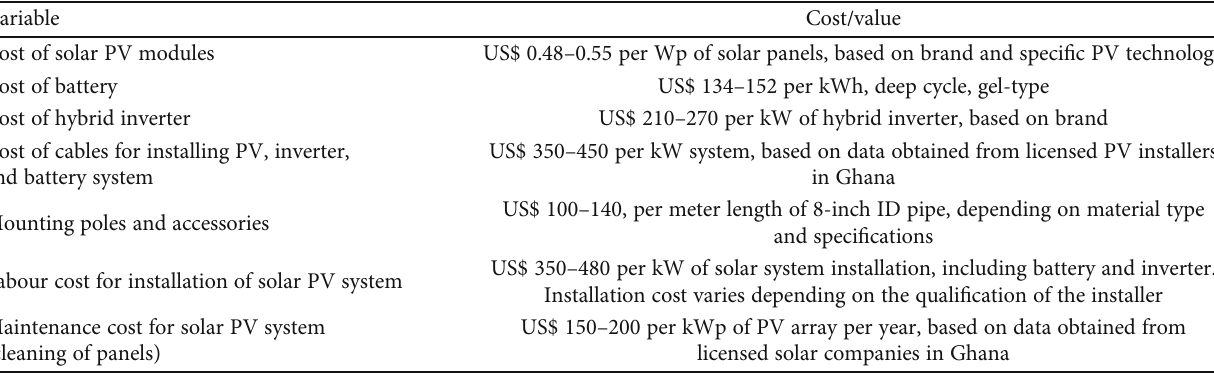
Figure 2: Standalone solar PV system at the CHPS compounds. Table 3: Unit cost per component of solar PV system installation in